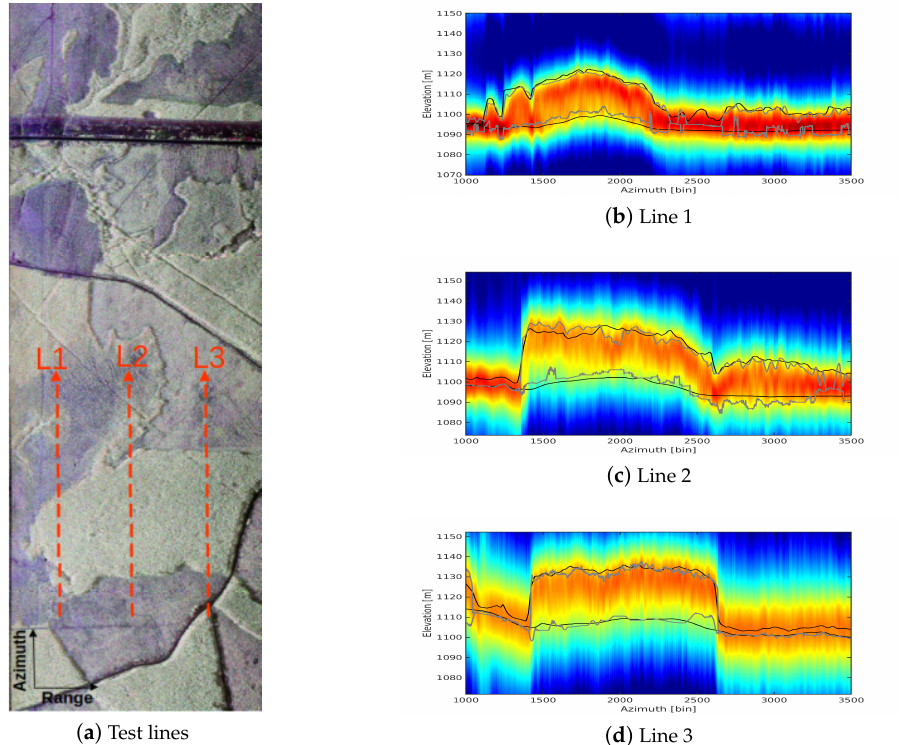
Figure 13. Ground topography and tree top heights estimated by the proposed tomographic approach. Background, P-Capon tomograms; gray line, estimated ground and tree top elevations; black line, LiDAR ground and tree top elevation